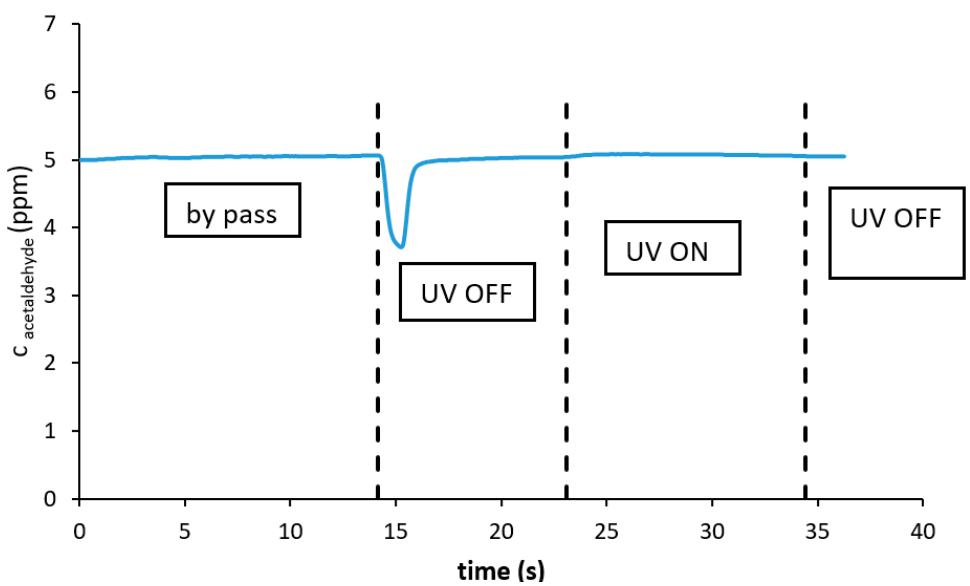
Figure 3. Removal of acetaldehyde on a film of Ex-CN (0.5 mg / cm 2 ).